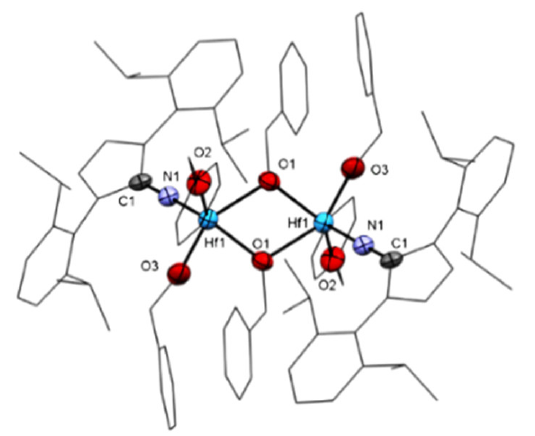
Figure 4. ORTEP drawing of 5 [(Im Dipp N) 2 Hf 2 (OBn) 6 ]. Hydrogen atoms are omitted for clarity. Selected bond lengths (Å) and angles (°): Hf-N1 = 1.971(7), Hf-O1 = 2.136 (5), Hf1-O1 = 2.198(6); Hf- O2 = 1.936(6), Hf-O3 = 1.958(7); N1-C1 = 1.251(10) Å; Hf-N1-C1 = 176.3(6), Hf-O1-Hf 1 = 113.2(2); O1- Hf-O1 1 = 66.8(2) (°).